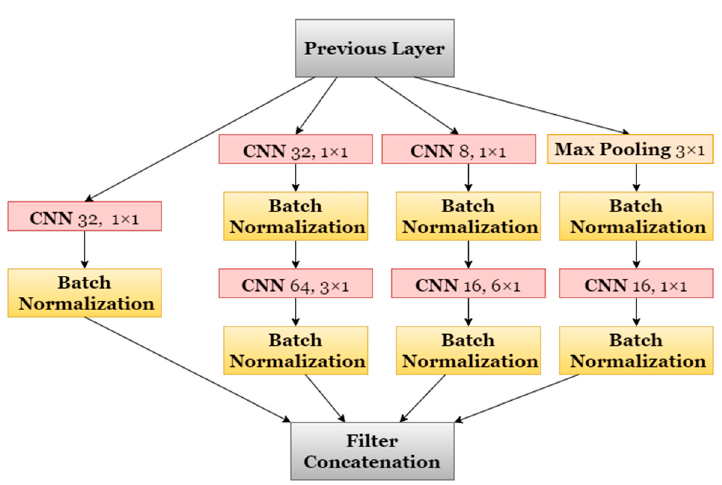
Figure 5. Architecture of Inception Block Type A.